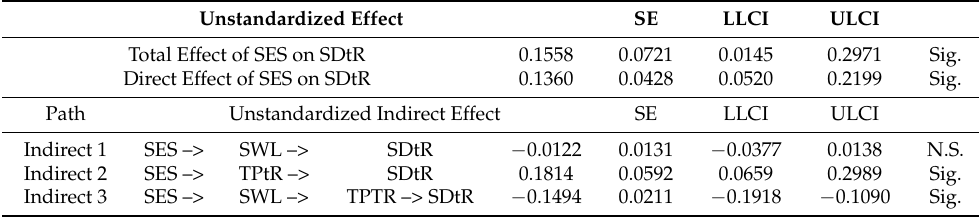
Table 6. Indirect effects of SES on SDtR.